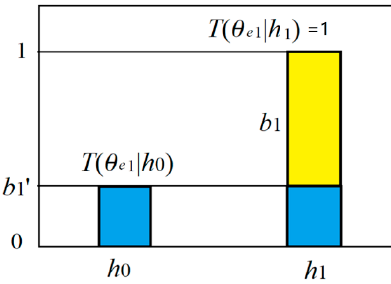
Figure 7. Truth function T ( θ e 1 | h ) includes the believable part with proportion b 1 and the unbelievable part with proportion b 1 ′ ( b 1 ′ = 1 − | b 1 |).